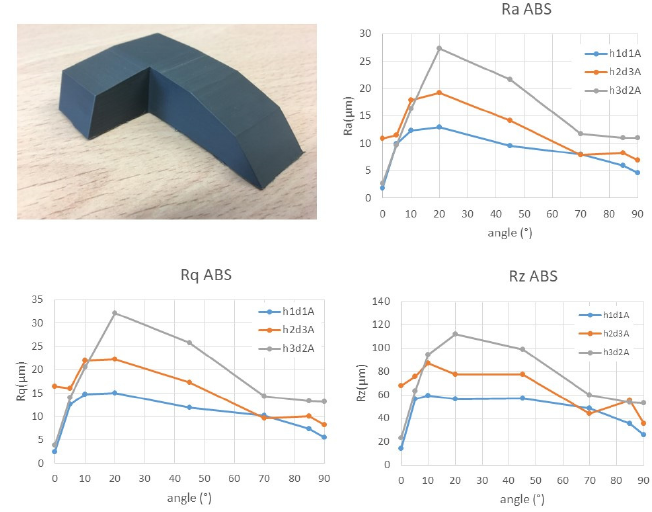
Polymers 2023 , 15 , x FOR PEER REVIEW Figure 7. Average Ra, Rq and Rz values for the ABS material. Figure 7. Average Ra, Rq and Rz values for the ABS material.